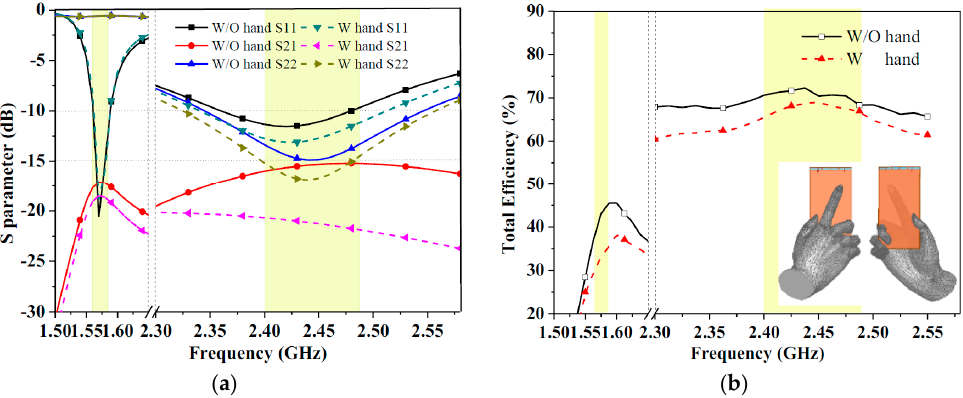
( b ) Figure 7. Simulated results with hand effect on ( a ) S-parameters and ( b ) Antenna efficiencies.